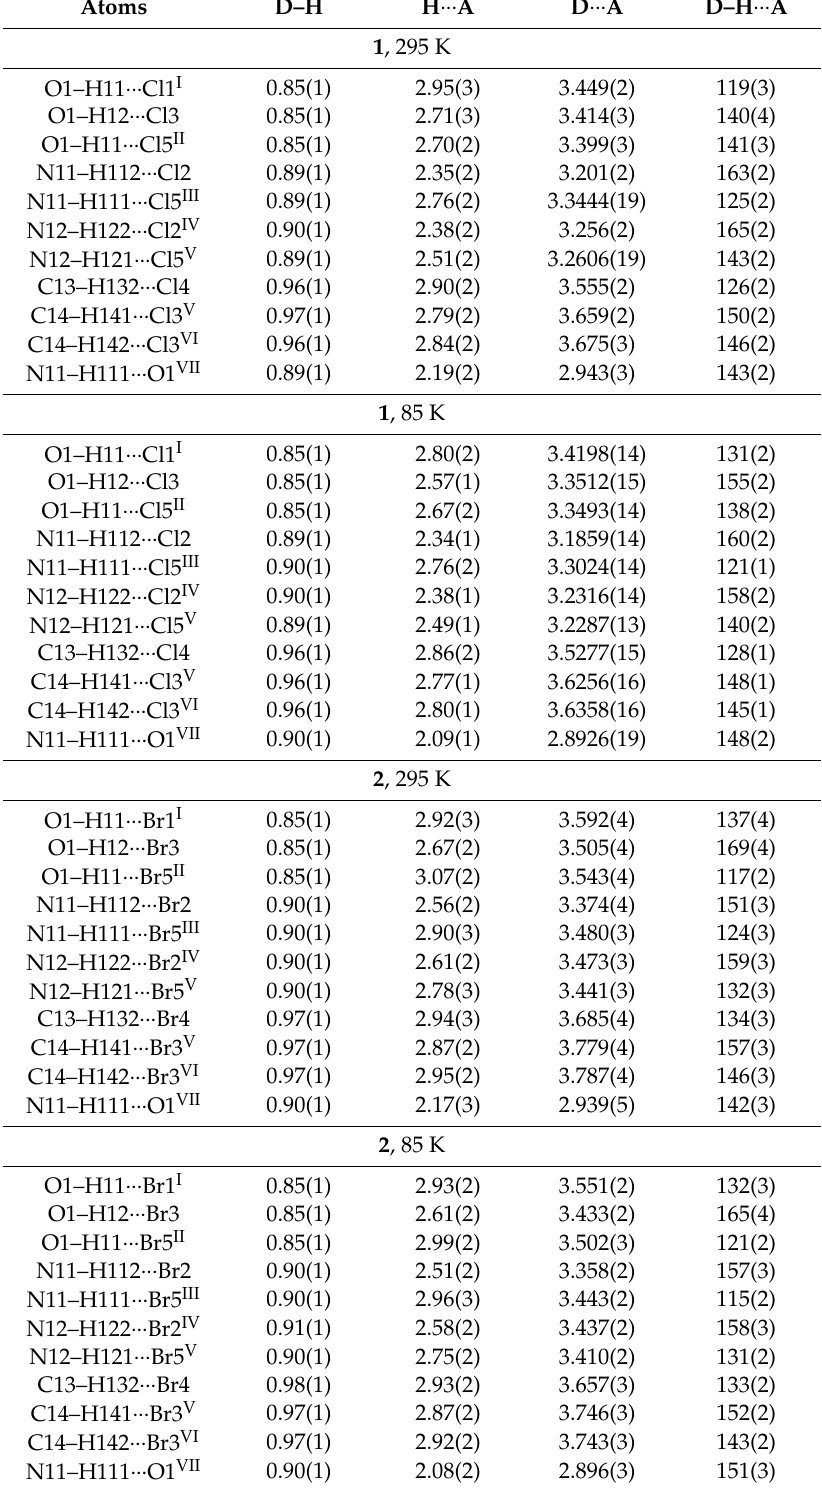
Table 3. Hydrogen bonds geometries (Å, ◦ ) for 1 and 2 at 295 and 85